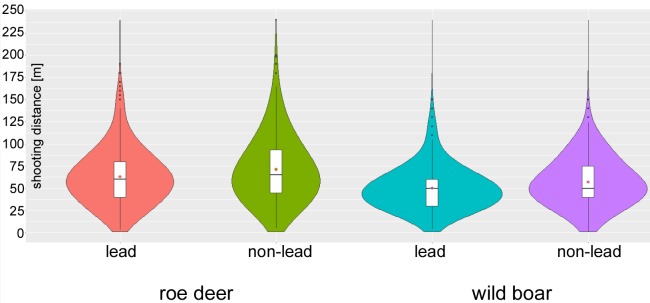
Shooting distance based on bullet material.The violin plot [36] combines the kernel density curve with the box plot. The box plot shows the median and the interquartile spacing. The mean is marked by the point.